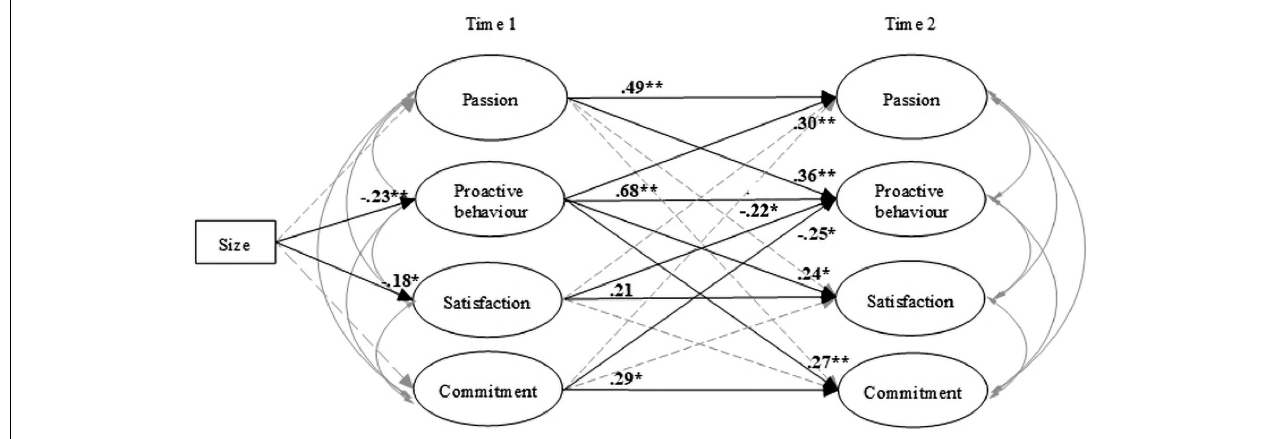
FIGURE 3 | Second part of the mediation model. The paths in grey are non significants paths and correlations. ** p < 0.01; * p < 0.05; ns, non-significant.